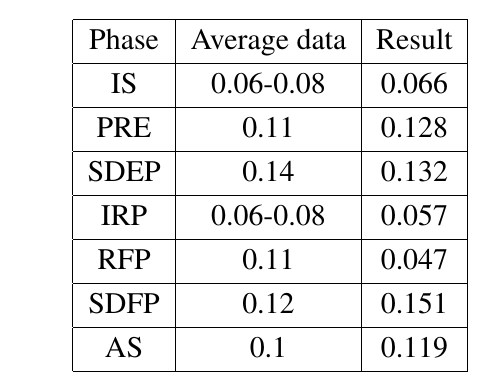
Table 2. CPP Lasting